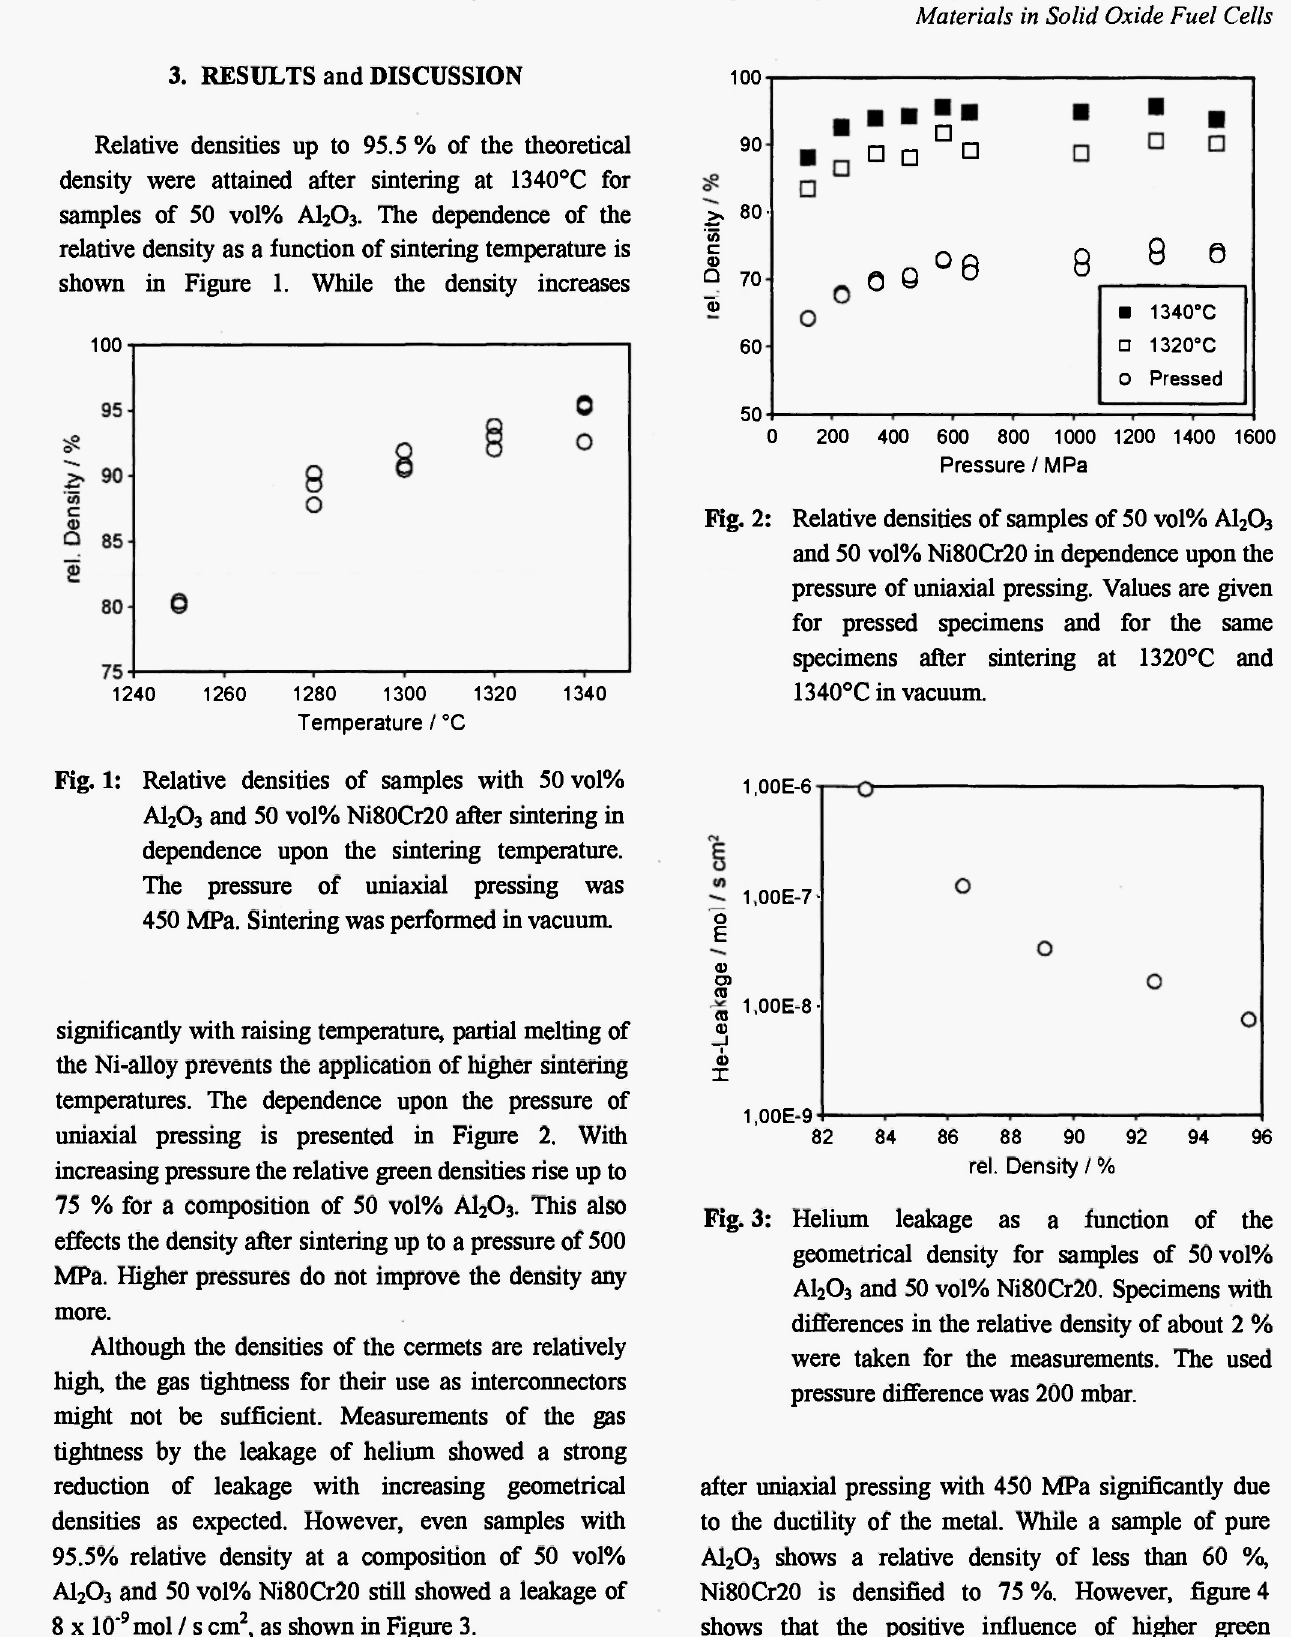
Fig. 3: Helium leakage as a function of the geometrical density for samples of 50vol% AI2O3 and 50 vol% Ni80Cr20. Specimens with differences in the relative density of about 2 % were taken for the measurements. The used pressure difference was 200